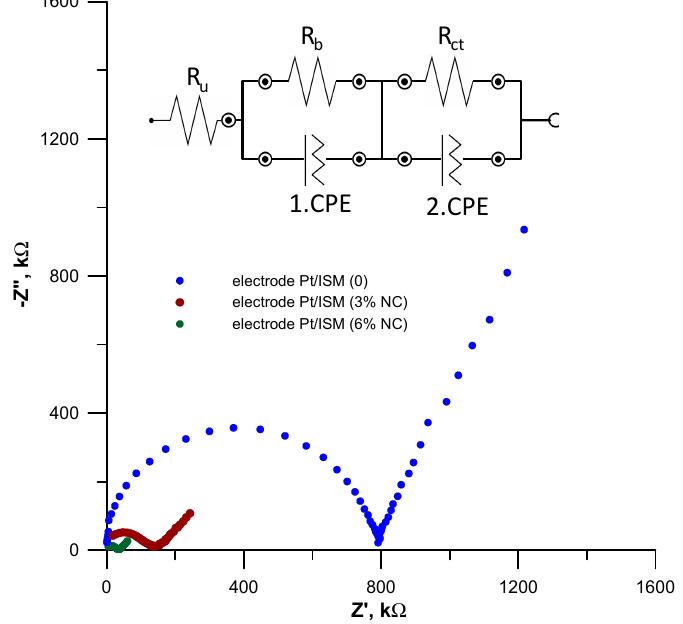
Figure 8. EIS spectra obtained for Pt/ISM (0), (Pt/ISM (3%NC)) and (Pt/ISM (6%NC)) electrodes determined in a 1 × 10 − 2 mol L − 1 Pb(NO 3 ) 2 solution. The inset shows the equivalent electrical circuit used to fit the data.